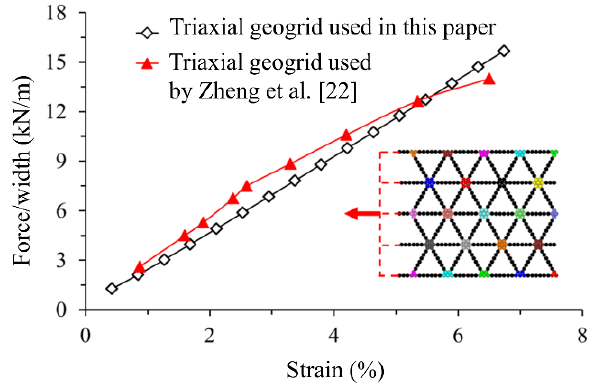
Figure 5. The tensile test curve of the triaxial geogrid.